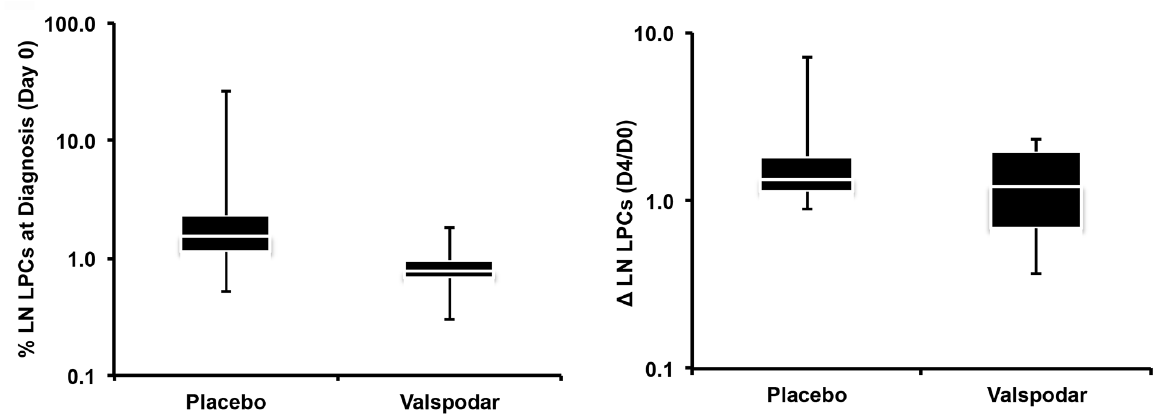
Figure 3. LPCs in lymph nodes from dogs with large B-cell lymphoma at diagnosis and on the fourth day of neoadjuvant treatment with valspodar. Left : Box plots showing median (white line), 75% confidence intervals, and outliers of the percent LPCs in lymph nodes at diagnosis, and Right : relative change in LPCs from the time of diagnosis (Day 0) to the fourth day of the neoadjuvant period (Day 4) in each group of dogs. A Δ LPC = 1.0 means no change in the percent LPCs measured at both time points. Data were analyzed and graphs were assembled using MS